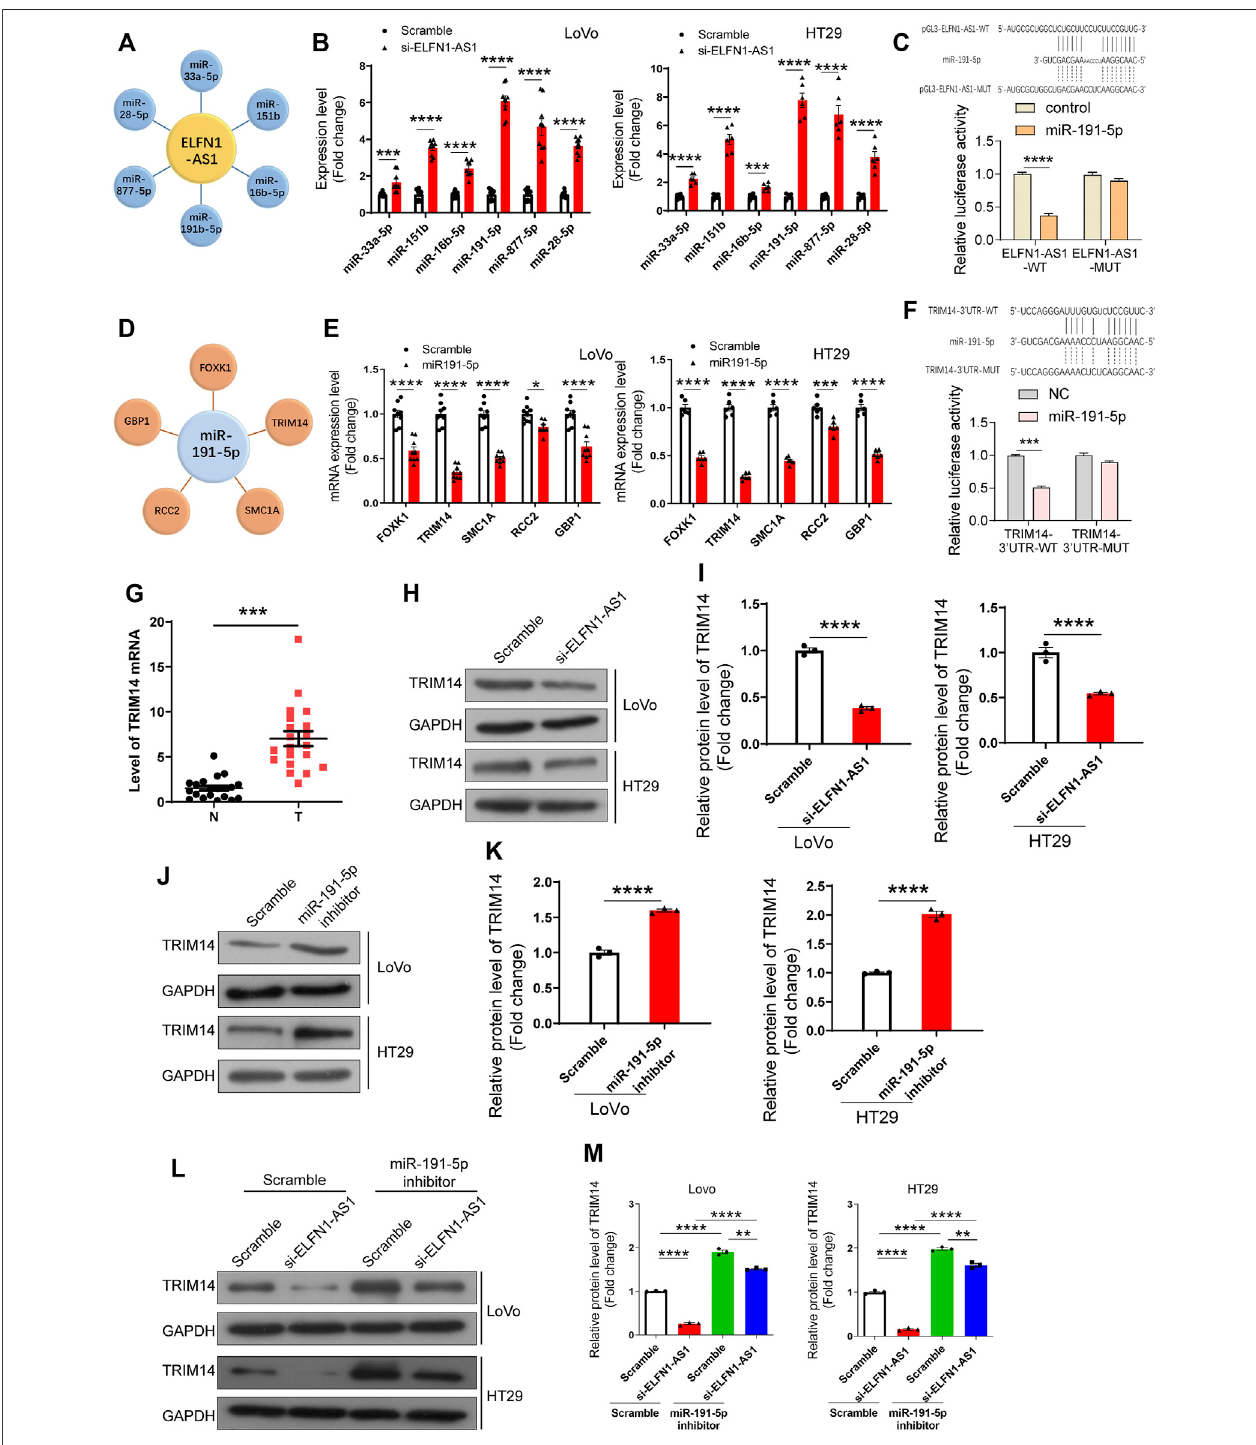
FIGURE 4 | Analysis and veri fi cation of ELFN1-AS1 ’ s downstream targets in colon cancer cells. (A) miRNAs with potential binding sites to ELFN1-AS1 were predicted in Diana tools (https://diana.e-ce.uth.gr/lncbasev3/interactions). (B) Six miRNAs (miR-33a-5p, miR-151b, miR-16b-5p, miR-191-5p, miR-877-5p, and miR- 28-5p) were detected in ELFN1-AS1 knockdown cells using qRT-PCR. (C) Interaction between miR-191-5p and ELFN1-AS1 was detected using luciferase reporter assay. (D) Potential downstream targets of miR-191-5p were also analyzed in Diana tools. (E) Five genes (FOXK1, TRIM14, SMC1A, RCC2, and GBP1) were veri fi ed in HT29 cells transfected with miR-191-5p mimics. (F) Interaction between miR-191-5p and TRIM14 was detected using luciferase reporter assay. (G) mRNA level of TRIM14 was detected in 32 pairs of clinical tissues of colon cancer using RT-PCR. A paired t -test was used for data analysis. (H) and (I) Protein level of